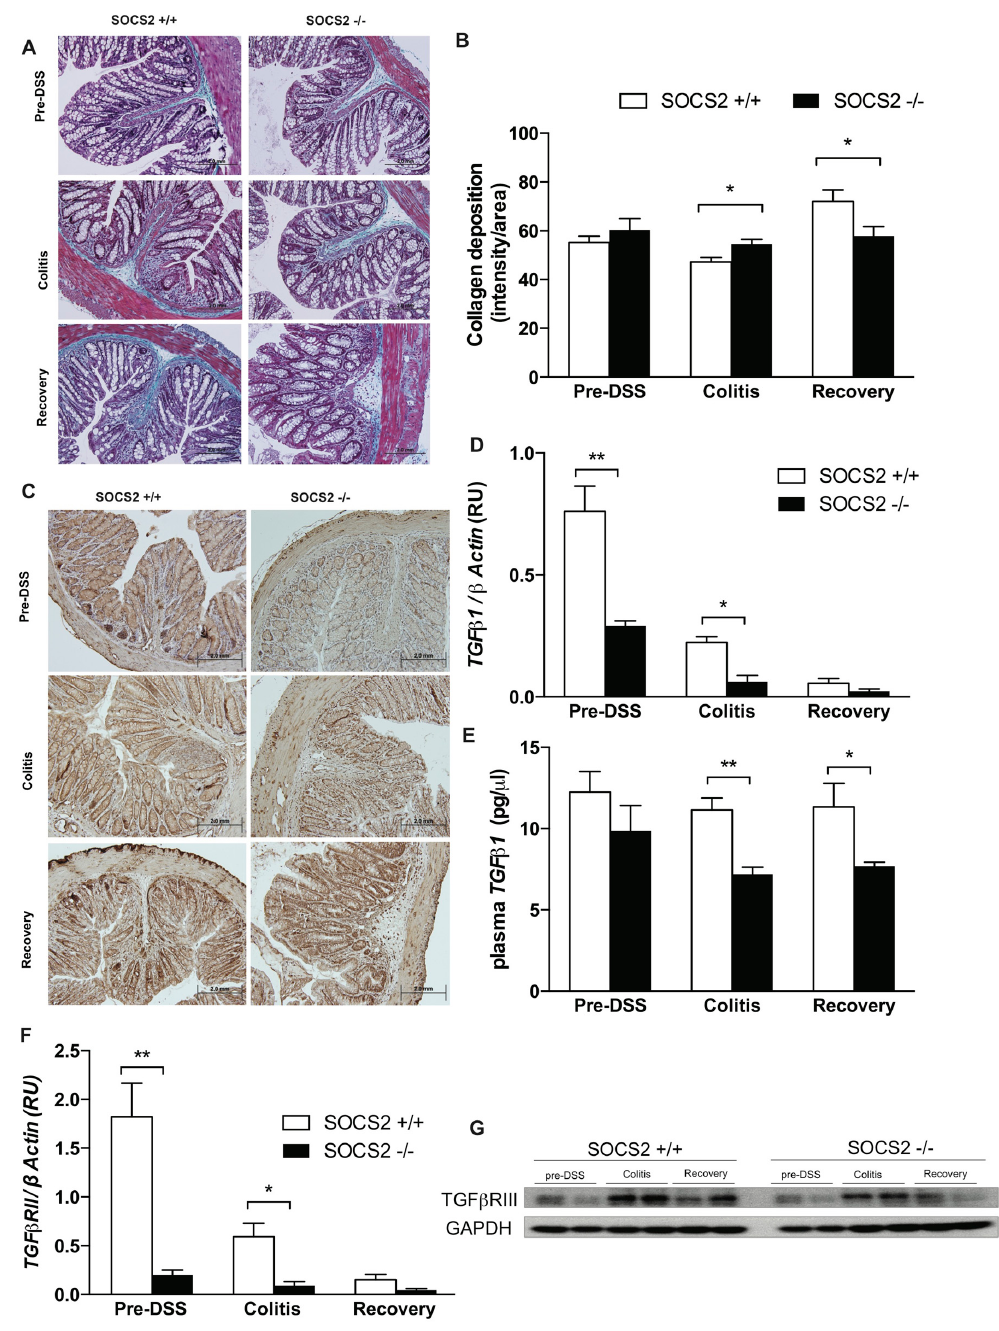
Figure 3. SOCS2-deletion induces less fibrosis in an inflammatory bowel model. ( A ) Masson’s Trichrome staining taken at 20X magnification prior, at colitis and after recovery from colitis in wild-type (SOCS2 +/+ ) and SOCS-knockout (SOCS2 − / − ) mice. ( B ) Collagen staining intensity in the study model measured from color threshold analysis using ImageJ tool. An average of 3 sections from each mouse was taken in a group of 5 mice. ( C ) immunohistochemistry of α -SMA in colonic sections. ( D , E ) TGF β 1 colonic gene expressions and plasma levels in both mice groups at the three time points of the study: pre-colitis, colitis and recovery. ( F ) TGF β RII gene expressions. ( G ) Western blot of TGF β -receptor III levels in both mice groups at the three time points of the disease model ( n = 2 per group). All gene expressions were normalized to the expression of the β -actin gene. Student’s t -test p -values: * < 0.05, ** <